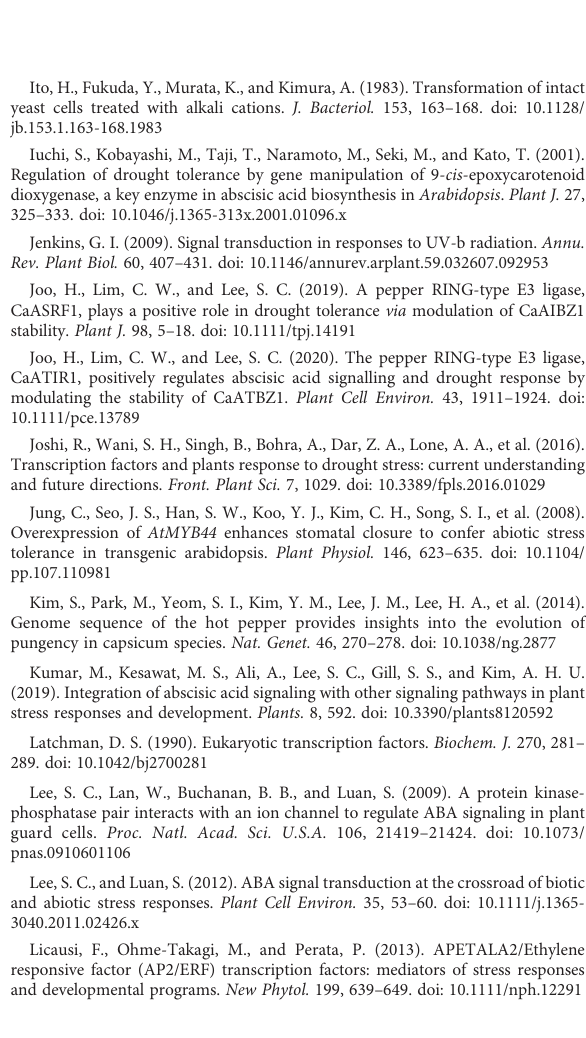
performed by using the deduced CaDIM1 and CaMYB102A amino acid sequences with highest similarity gathered from Arabidopsis. Multiple sequence alignment was performed using Clustal Omega (http://www. ebi.ac.uk/Tools/msa/clustalo/) with the default settings. The phylogenetic